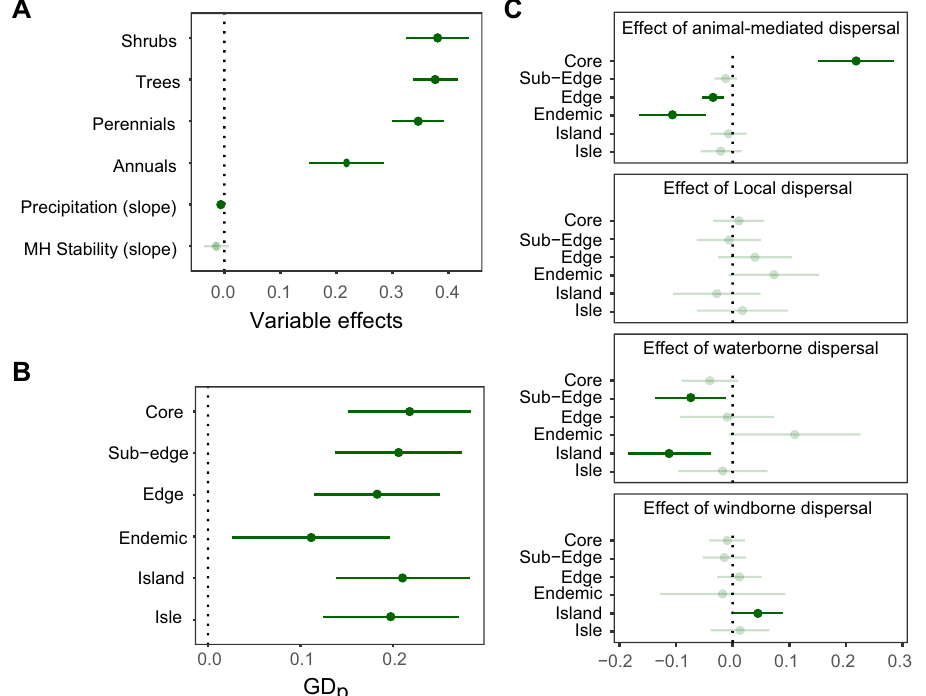
Fig. 5 Effects of variables on plant GD P . The panels represent 95% con fi dence intervals with mean phylum-independent effects of lifeform, precipitation and climate stability ( A ), biogeographic position ( B ) and seed dispersal-dependent effects of biogeographic position ( C ), as derived from the plant kingdom model (Supplementary Data 7). Non-signi fi cant effects (p-values > 0.05) are transparent. Source data are provided as a Source Data fi